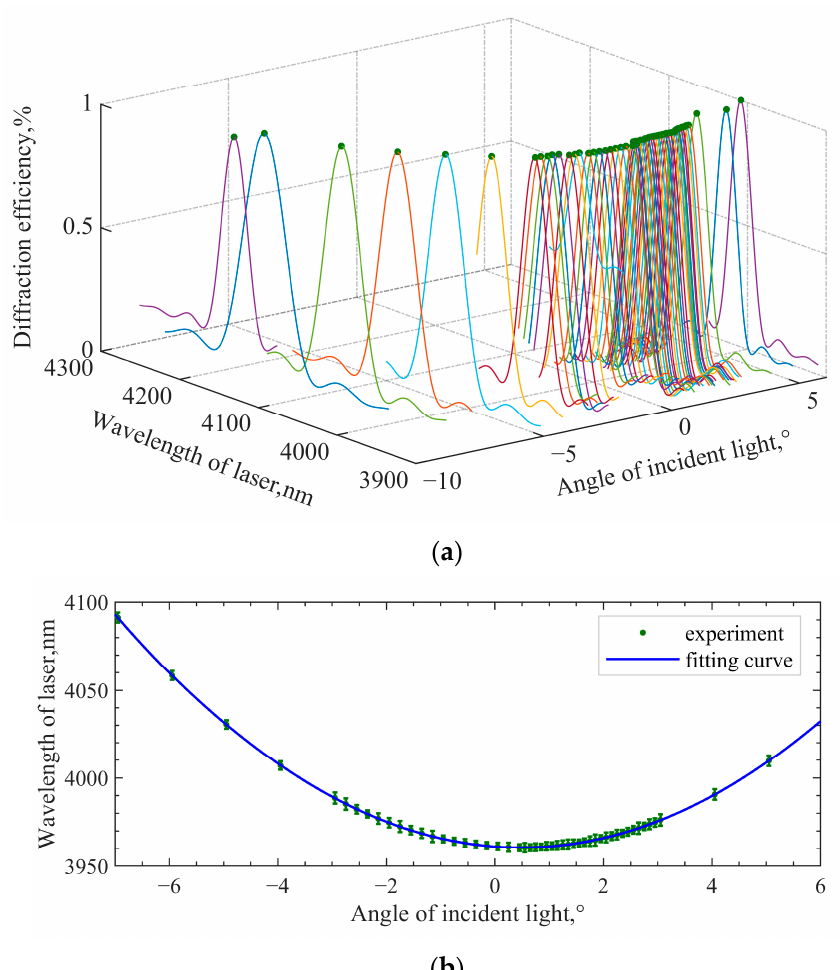
Figure 7. Measurement and fitting results of the minimum-central wavelength method. ( a ) Three- dimensional diagram of spectral responses at different angles; ( b ) fitted curve of central wave ‐ lengths.